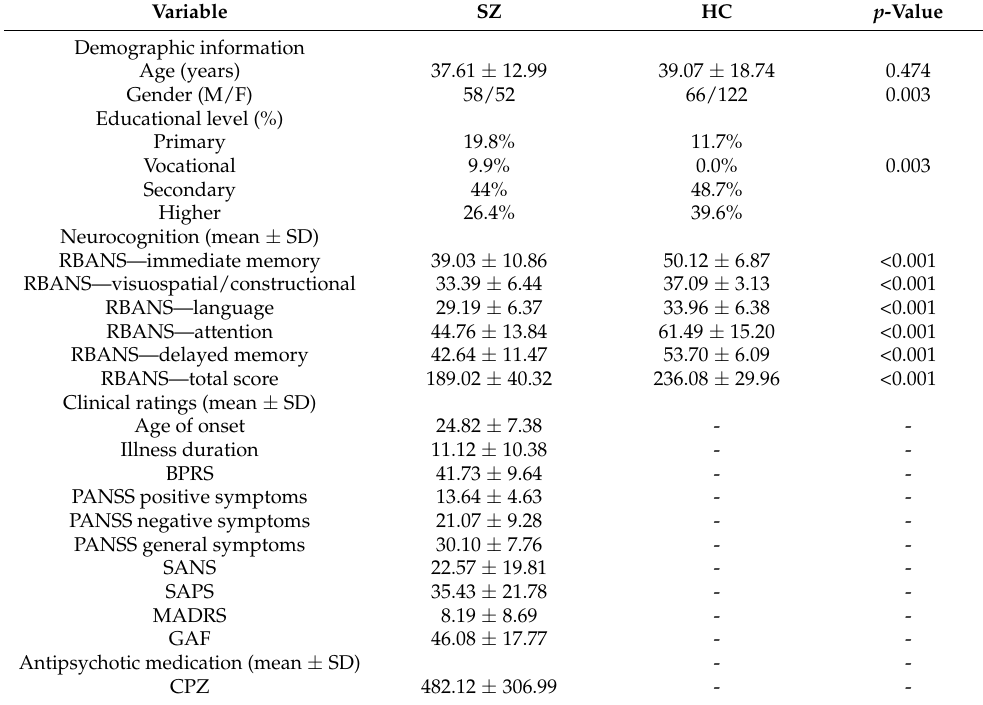
Table 1. General characteristic of the SZ patients and HC